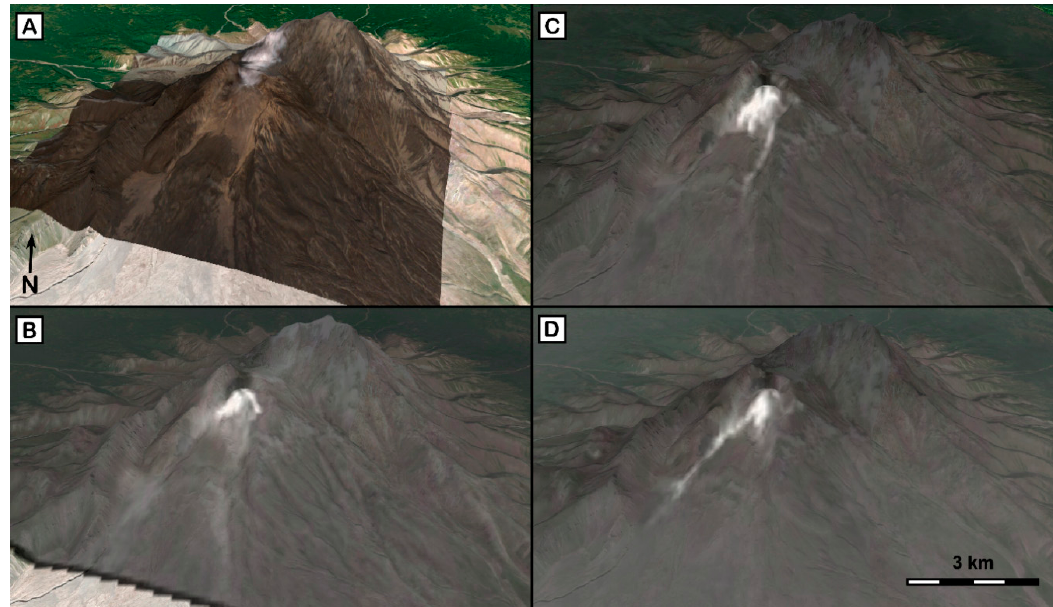
Figure 9. An example of the improved time series made possible by the ASTER URP Program, here showing the ASTER data draped over a 3D Google Earth visible image viewed looking NW toward Sheveluch volcano, Russia (summit location: 56.65 ◦ N, 161.36 ◦ E). ( A ) ASTER VNIR image acquired on 20 April 2019. The small white plume is visible drifting to the north. ( B ) ASTER TIR data from the same date. Two thermally elevated regions are seen on the summit lava dome. ( C ) ASTER nighttime TIR image acquired ~36 h later (21 April 2019) showing a significant increase in the area of the thermally elevated region on the dome and a ~2 km flow down the eastern side of the valley. ( D ) ASTER nighttime TIR data acquired on 28 April 2019 showing the continued, but somewhat lower, thermal activity on the dome and a new debris flow extending ~3 km down the western side of the valley.